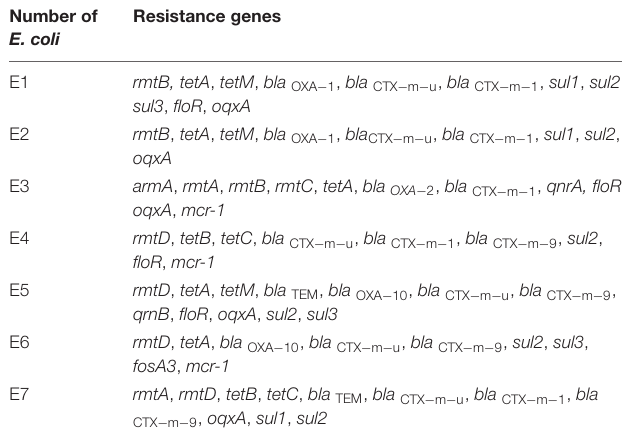
TABLE 1 | Resistance genes of the seven strains of E. coli . Number of E.